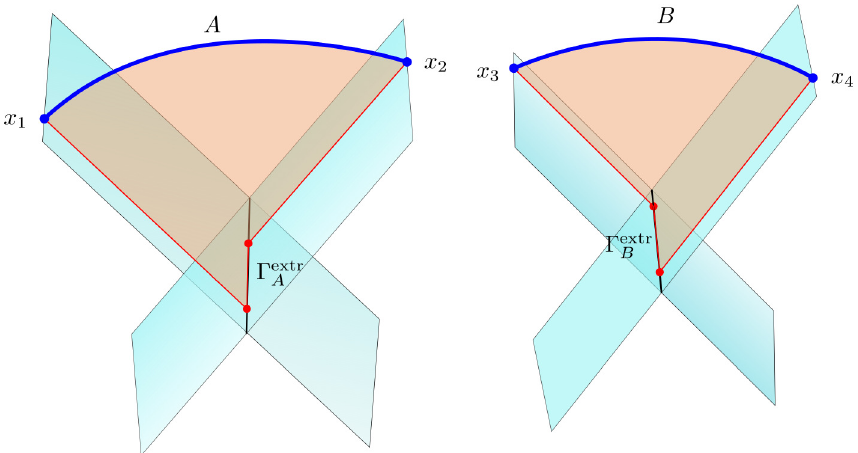
Figure 3: Two disjoint intervals A and B in a GCF T asymptotically flat spacetime, such that their entanglement wedge remains discon- nected and correspondingly the EWCS is identically